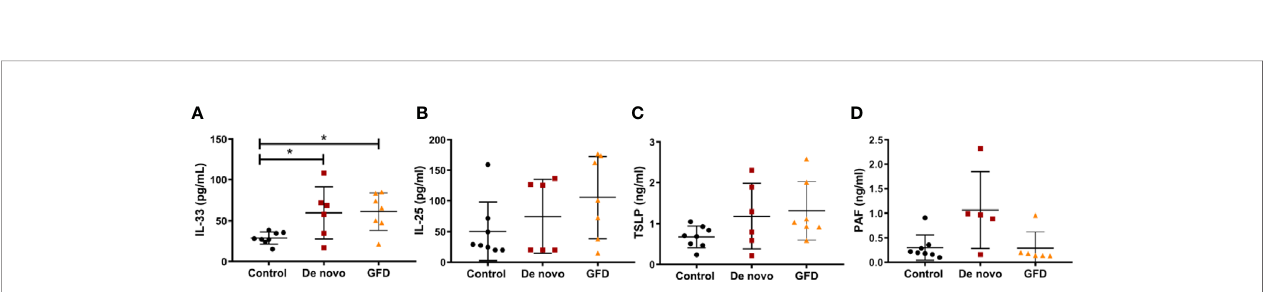
FIGURE 5 | mRNA expression of de novo diagnosed CD patients ( de novo ) (n = 6) and CD patients on GFD (GFD) (n = 7) for IL-15 (A) , IL15Ra (B) , IFN g (C), and perforin (D) . Fold change is referred to non-celiac (control) samples using 2 - DD CT method, data were normalized using two housekeeping genes (GAPDH and b -actin). Bar plots show mean ± SD *p < 0.05, **p <0.01.